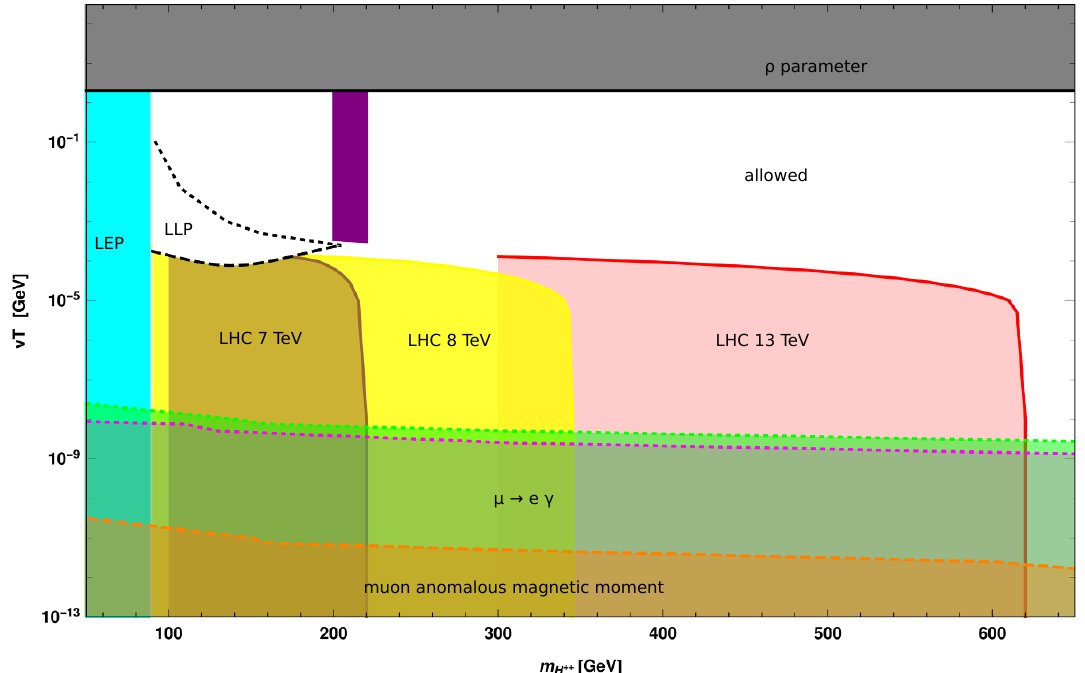
Figure 8 . Parameter space of the type-II seesaw model. The black area in top is excluded because of the (cid:26) parameter. The cyan vertical area is the estimate for the excluded region by searches at LEP. The orange region on the bottom is excluded by the experimental measurement for the muon anomalous magnetic moment. The magenta area is excluded by (cid:22) e(cid:13) (for our example choice ! of PMNS parameters and neutrino mass spectrum) and the green area is excluded by constraints on (cid:22) (cid:22) eee . The red, yellow and brown areas are excluded by the LHC searches for same sign ! di-lepton (cid:12)nal states at 7, 8 and 13 TeV. The purple area is excluded by LHC searches for same-sign W bosons. Finally, the white area is allowed. The part of the white area inside the dashed and dotted black lines on the left (denoted by LLP) features displaced decays from long-lived H (cid:6)(cid:6) . The lower dashed line is obtained from the limit on the prompt decays as described in the main text. The upper dotted line (where no experimental constraints exist to date) shows the region where c(cid:28) > 1 mm. Above this line the dominant decay is the three-body decay to W (cid:6) f (cid:22) f 0